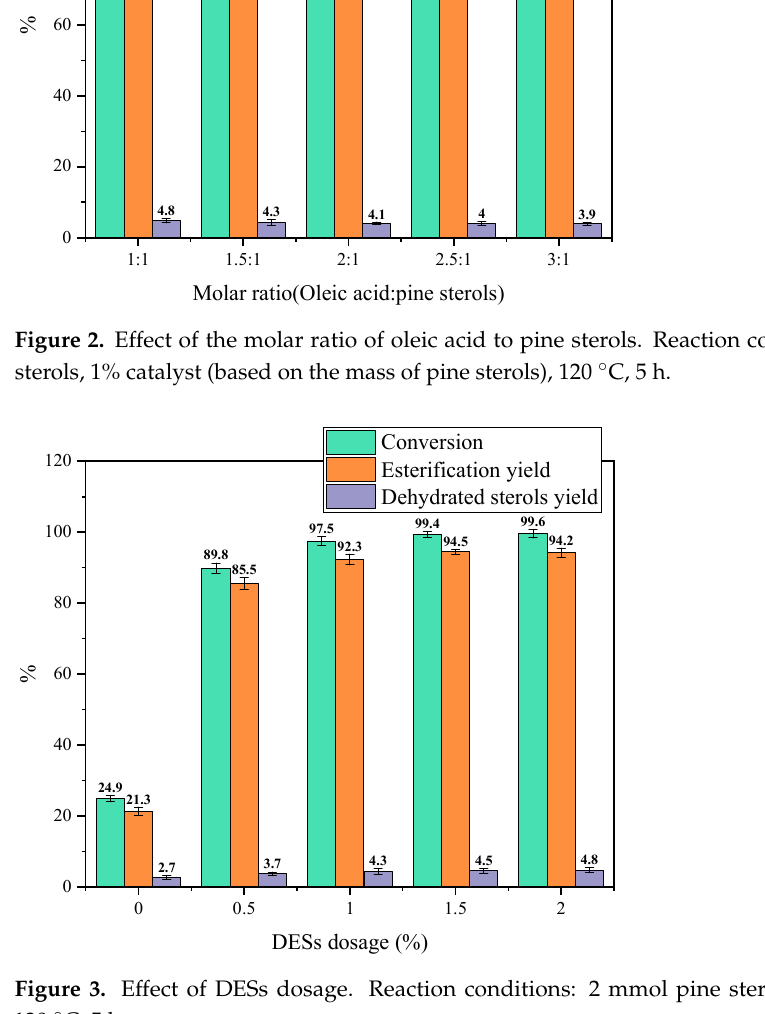
Figure 4. Effect of reaction temperature. Reaction conditions: 2 mmol pine sterols, 3 mmol oleic acid, 1.5% catalyst (based on the mass of pine sterols), 5 h. The effect of reaction time was summarized as shown in Figure 5. The conversion of pine sterols and product yield reached 91.1% and 87.0% at 2 h, respectively, and the growth rate gradually slowed down with the extension of time. The reaction reached